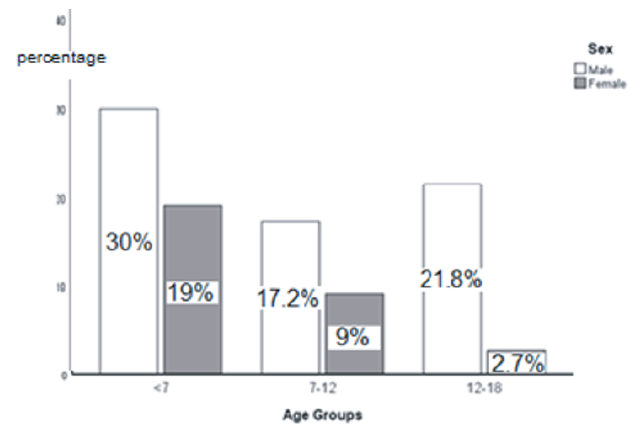
Figure 1. Distribution of trauma according to sex and age groups.